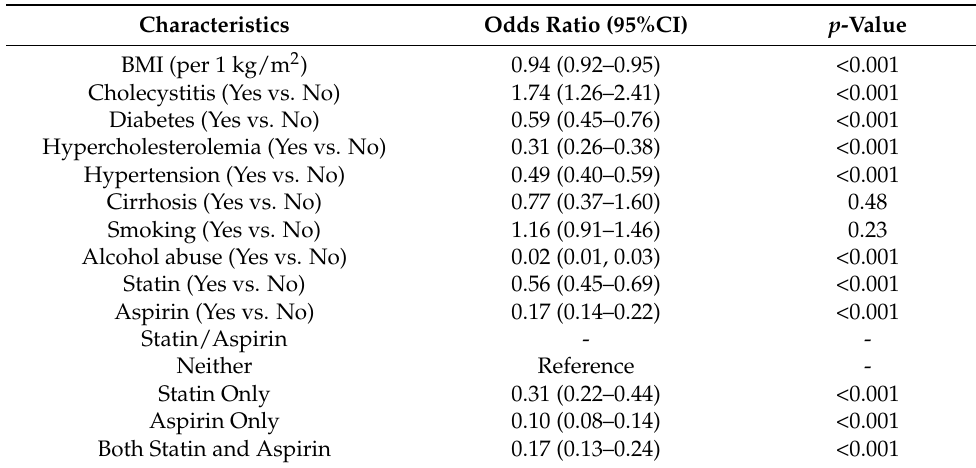
Table 4. Univariable analysis excluding potential confounders’ inflammatory bowel disease and primary sclerosing cholangitis.